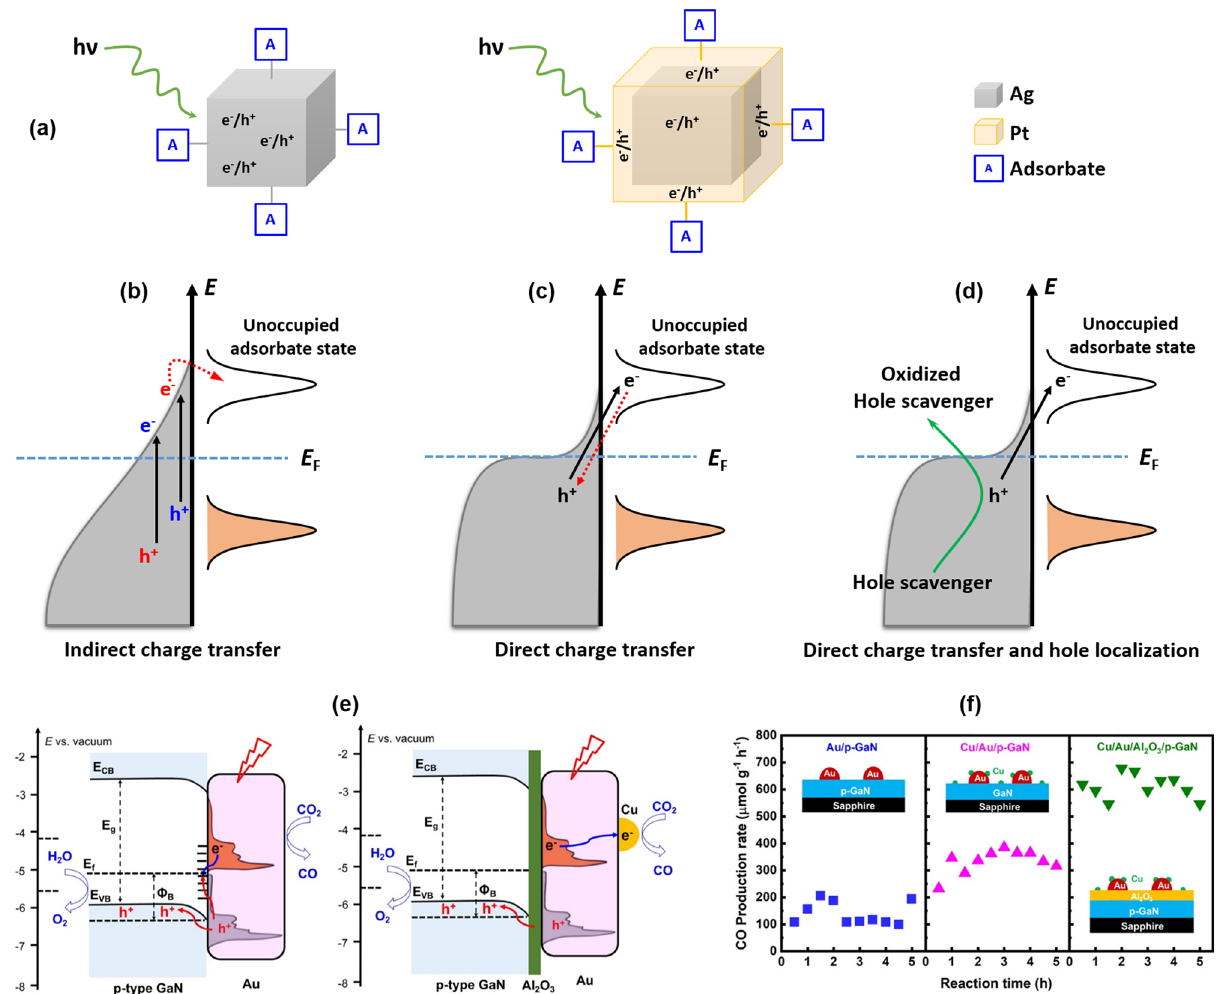
Fig. 6 Importance of charge localization to a catalytic site and hole extraction in photocatalysis. a , Schematic of Ag and Ag-Pt core-shell nanomaterials, the Ag-Pt nanocomposite allows preferential absorption of plasmon energy from the core to the thin Pt-shell, leading to charge generation and extraction in the presence of suitable adsorbate and hole scavenger. b – d Illustration of various charge transfer mechanisms. In the absence of hole scavenger both direct and indirect charge transfer mechanism leads to transient charge exchange between nanomaterial and adsorbate; however, the presence of hole scavenger allows permanent ejection of an electron to the adsorbate leading to the catalytic reaction. ( a – d adapted with permission from ref. 52 copyright © 2019, American Chemical Society). e Hot hole injection from Au into the p-GaN valence band and the effect of introducing an interfacial layer of Al 2 O 3 . The Al 2 O 3 interfacial layers passivate the surface defects leading to a longer lifetime of hot carriers. f Photocatalytic CO production rate with time highlights 69% enhancement in the Au/Al 2 O 3 /p-GaN composite rate compared to Au/p-GaN ( e , f reprinted with permission from ref. 60 copyright © 2021, American Chemical